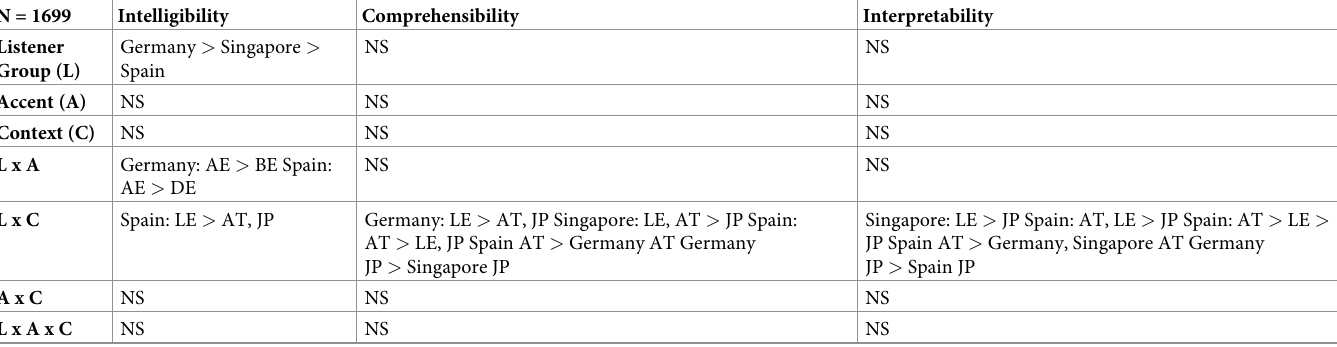
Table 2. Summary results speech understandability (Intelligibility, Comprehensibility, Interpretability).